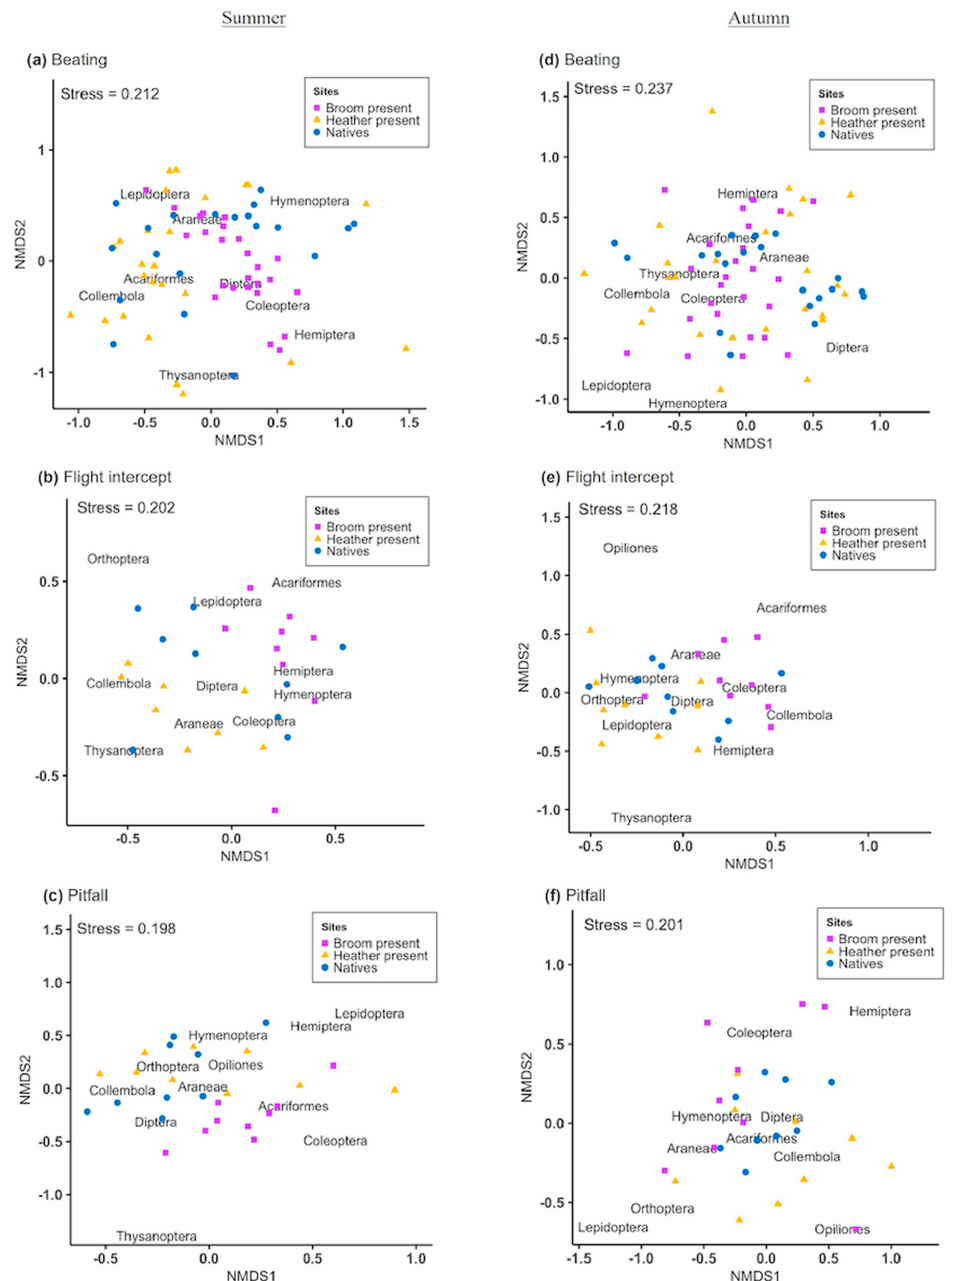
Figure 1. Non-metric multidimensional scaling (NMDS) plots for arthropod community composition in weed-invaded and non-invaded sites in summer ( a – c ) and autumn ( d – f ). Arthropods were caught by beating tray method, flight intercept, and pitfall traps.